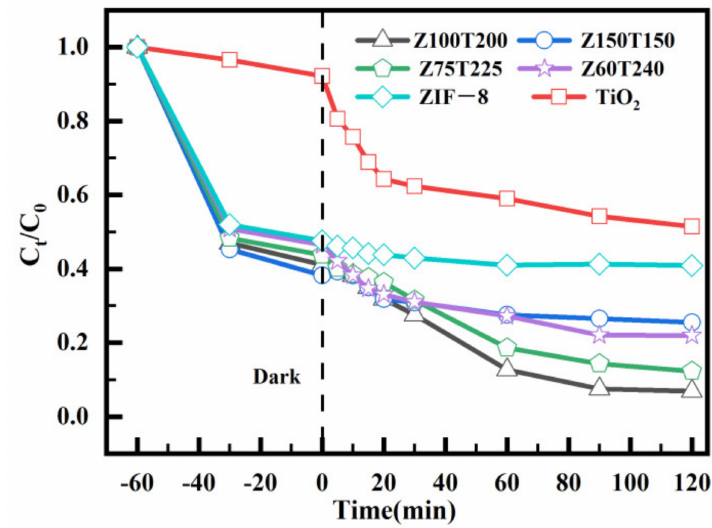
Figure 5. Removal efficiencies for Cr(VI) of, TiO 2 , and ZIF-8 and ZIF-8@TiO 2 (Z x T y ).